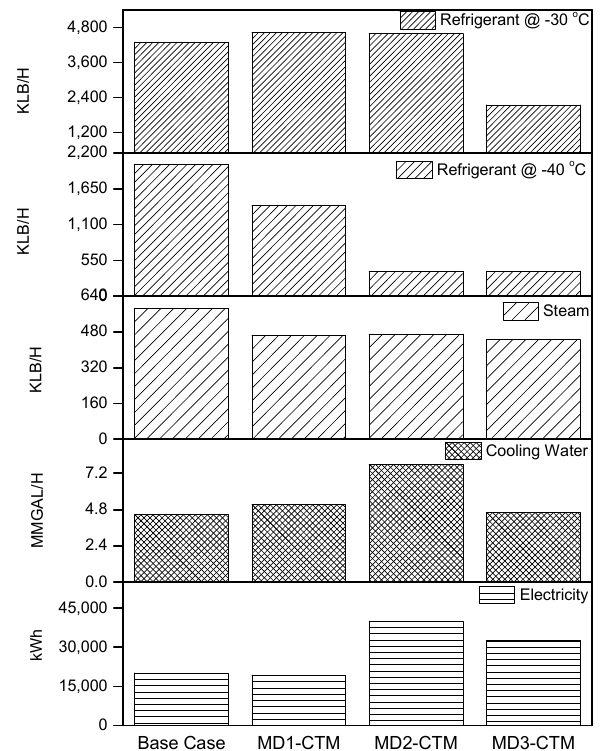
Figure 14. Utilities consumption rates for the four CTM processes.